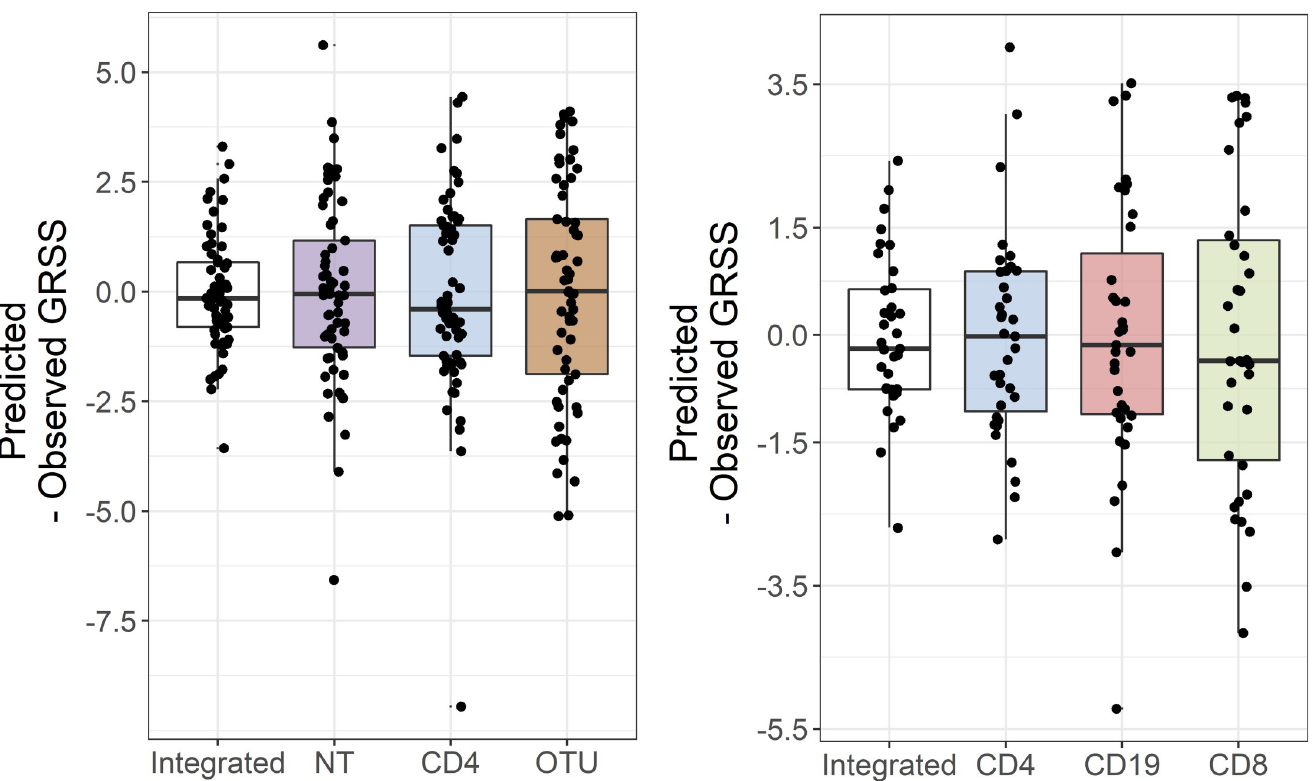
Fig 3. Integration of different data modalities improves prediction of GRSS. The panel on the left shows the difference between the predicted and observed GRSS for a model that integrates the nasal epithelial transcriptome, peripheral blood CD4 transcriptome, and nasal microbiome, as well as for models using just one of these data types. Similarly, the panel on the right compares a model that integrates the transcriptomes of 3 immune cell types measured in peripheral blood with models using just one of these data types. In both cases, integration increases the precision of the GRSS predictions.